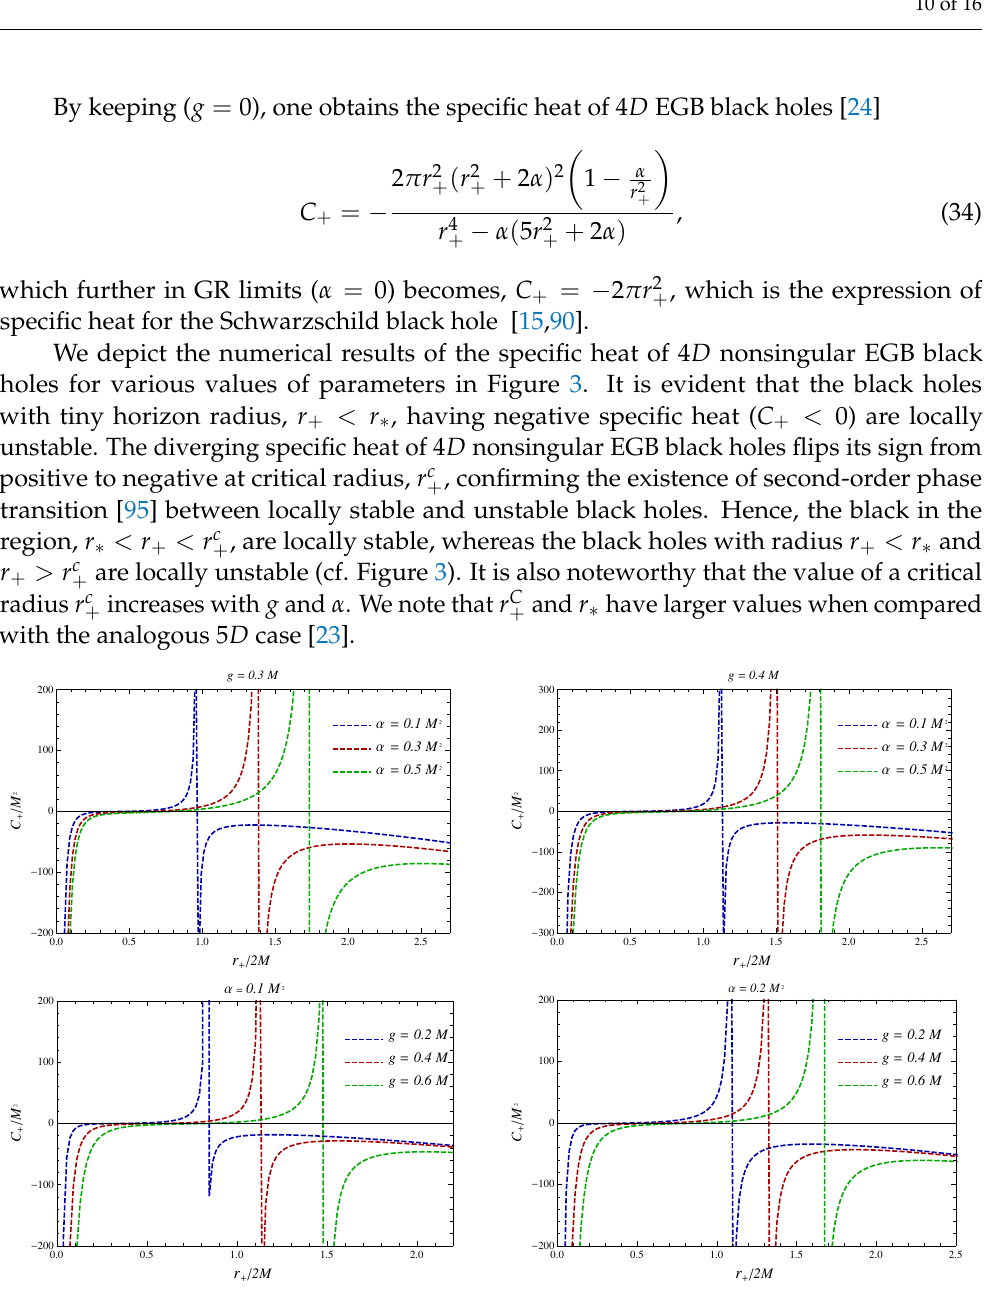
Figure 3. 4 D nonsingular EGB black holes specific heat C + vs. horizon r + for different values of α and g